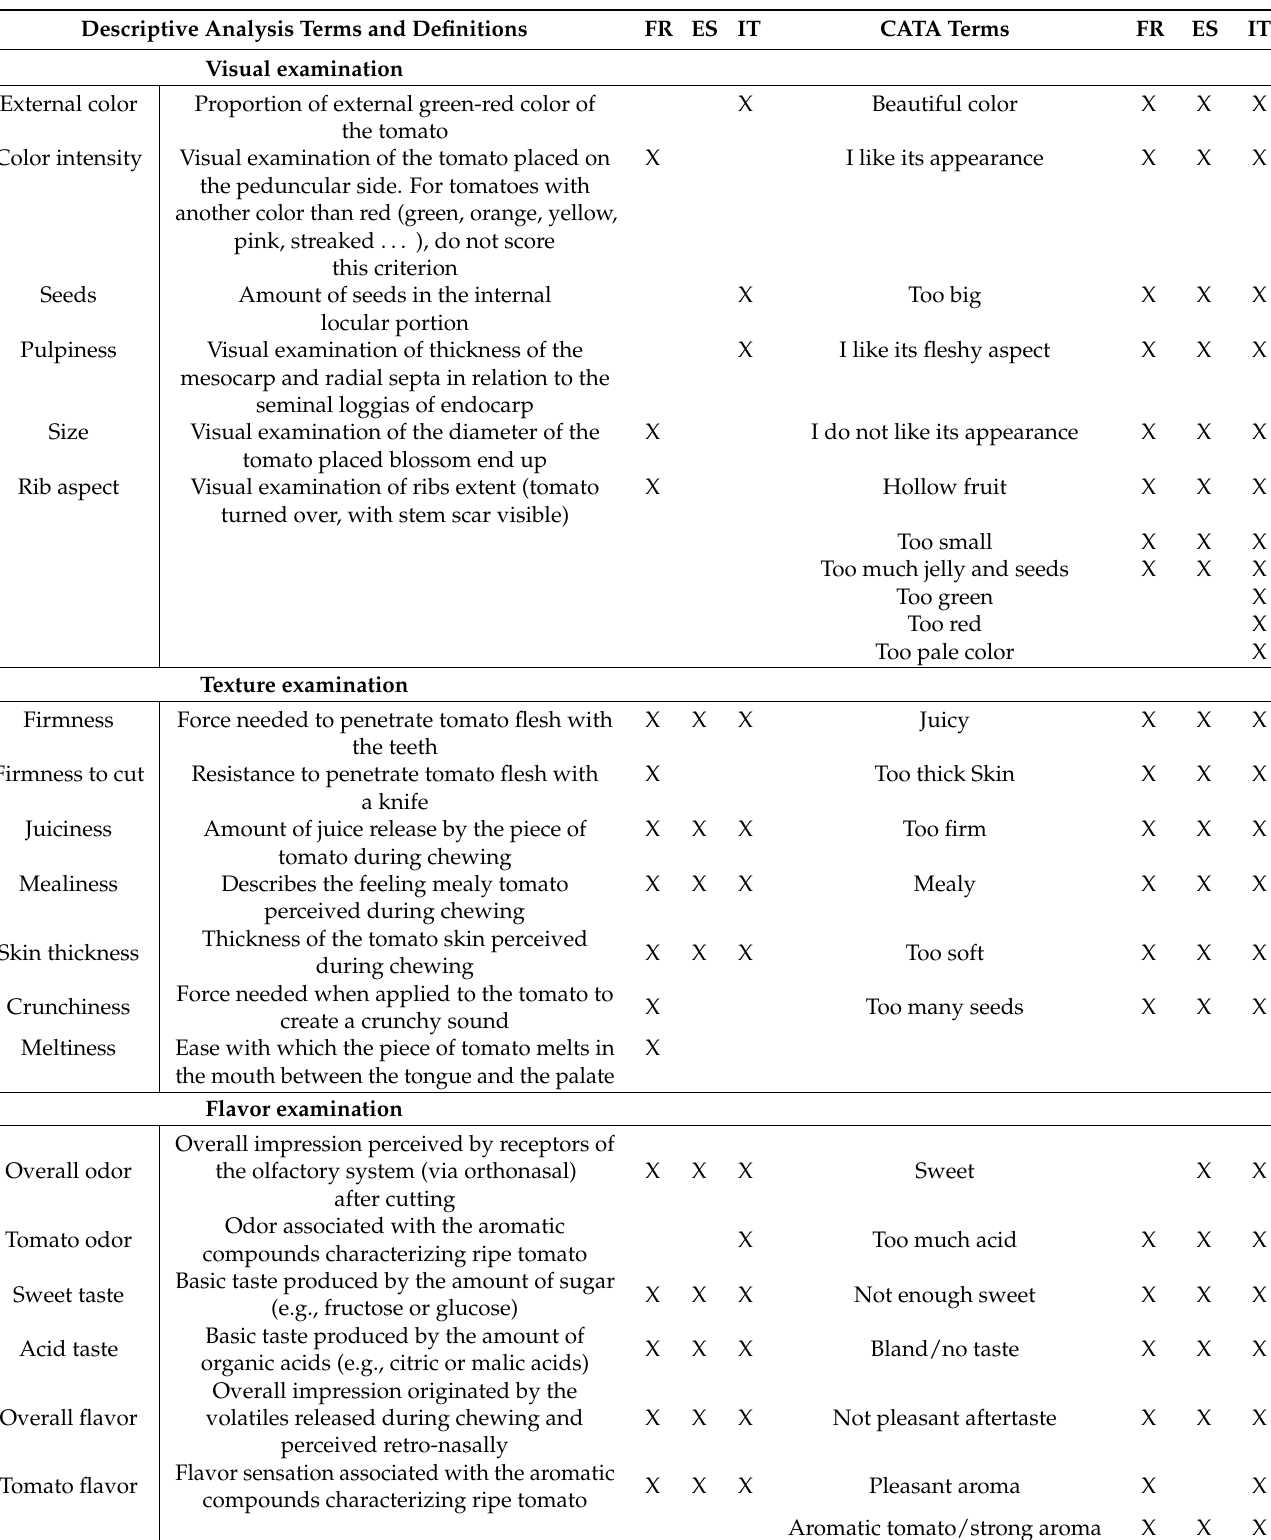
Table 2. Sensory descriptors determined by the trained taste panel and list of CATA terms in the consumer tests in each